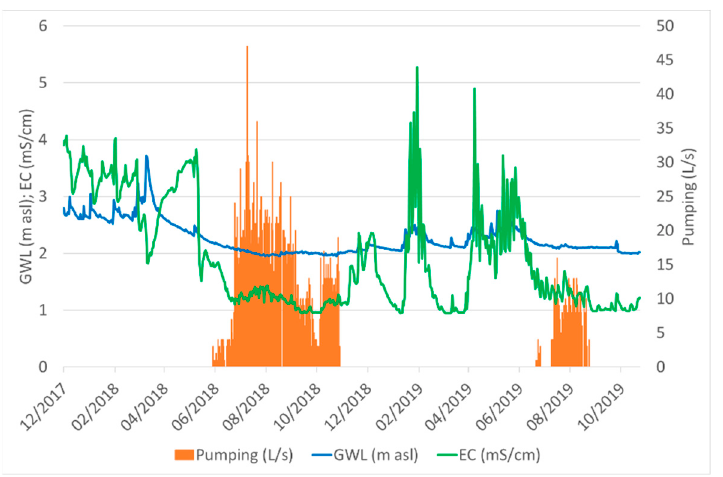
Figure 7. Electrical conductivity, groundwater level, and pumping rates on the Boljkovac water sup- ply facility. supply